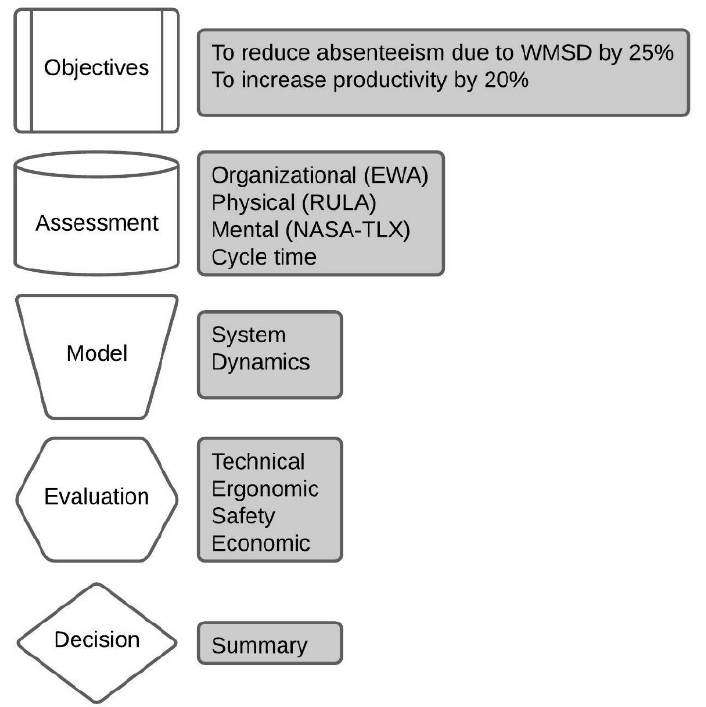
Figure 4. Applied framework for ergonomic assessment in a workstation with an HRC system.